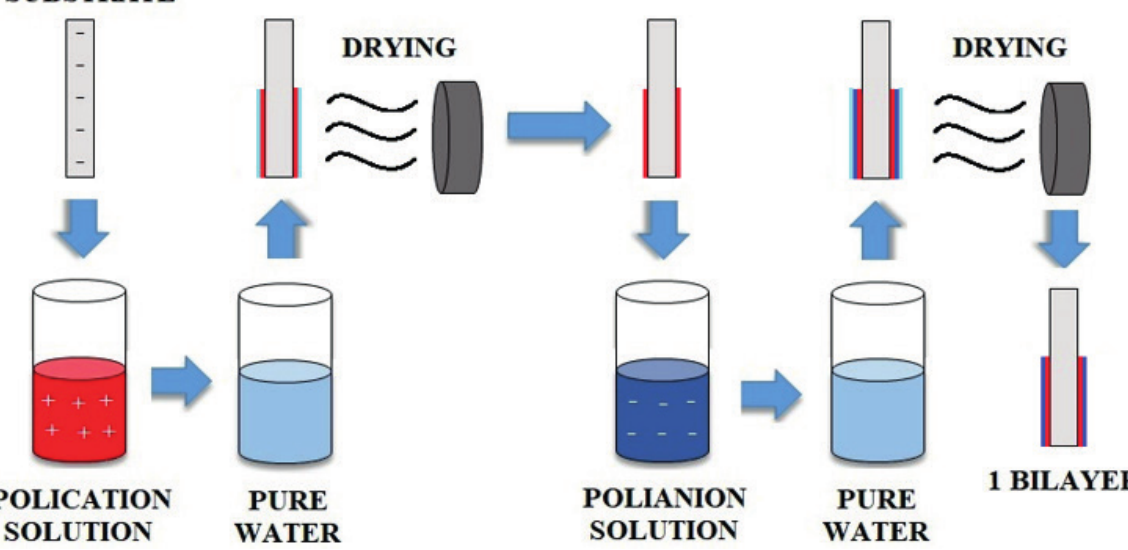
Figure 1 - Schematic representation of LbL method for fabrication of nanostructured multilayer